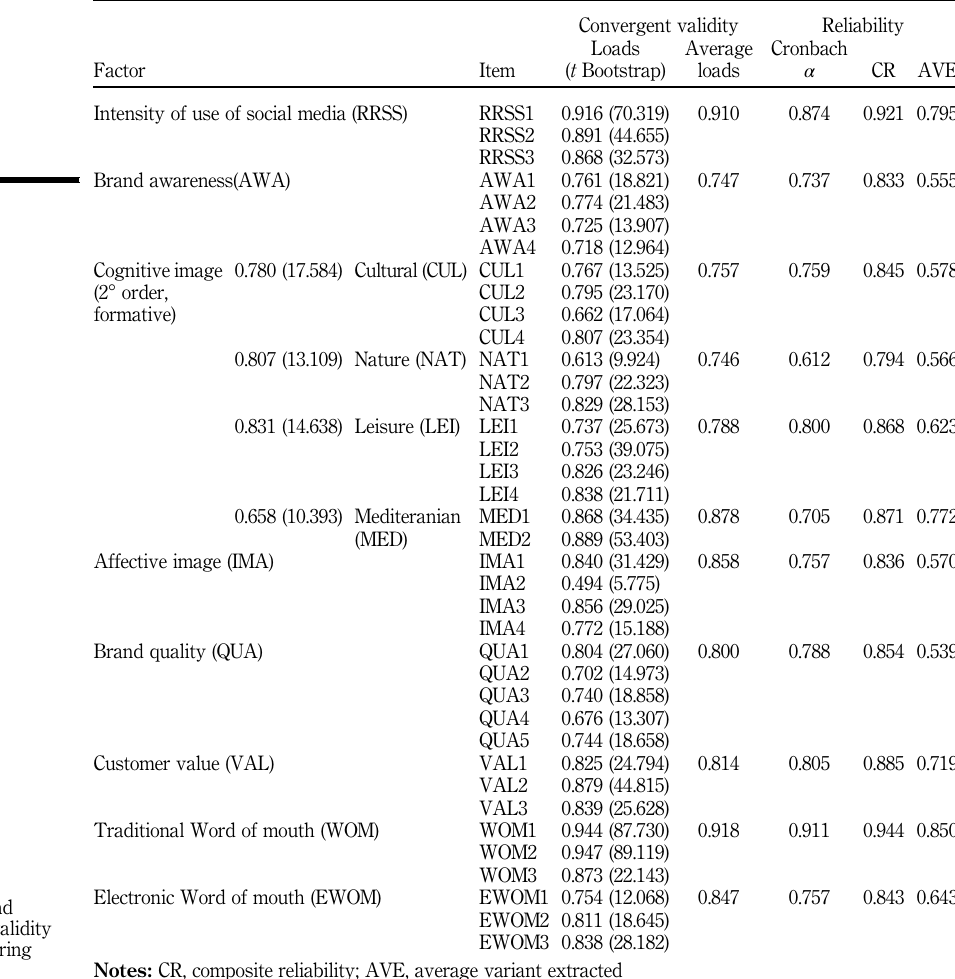
convergent validity of the measuring